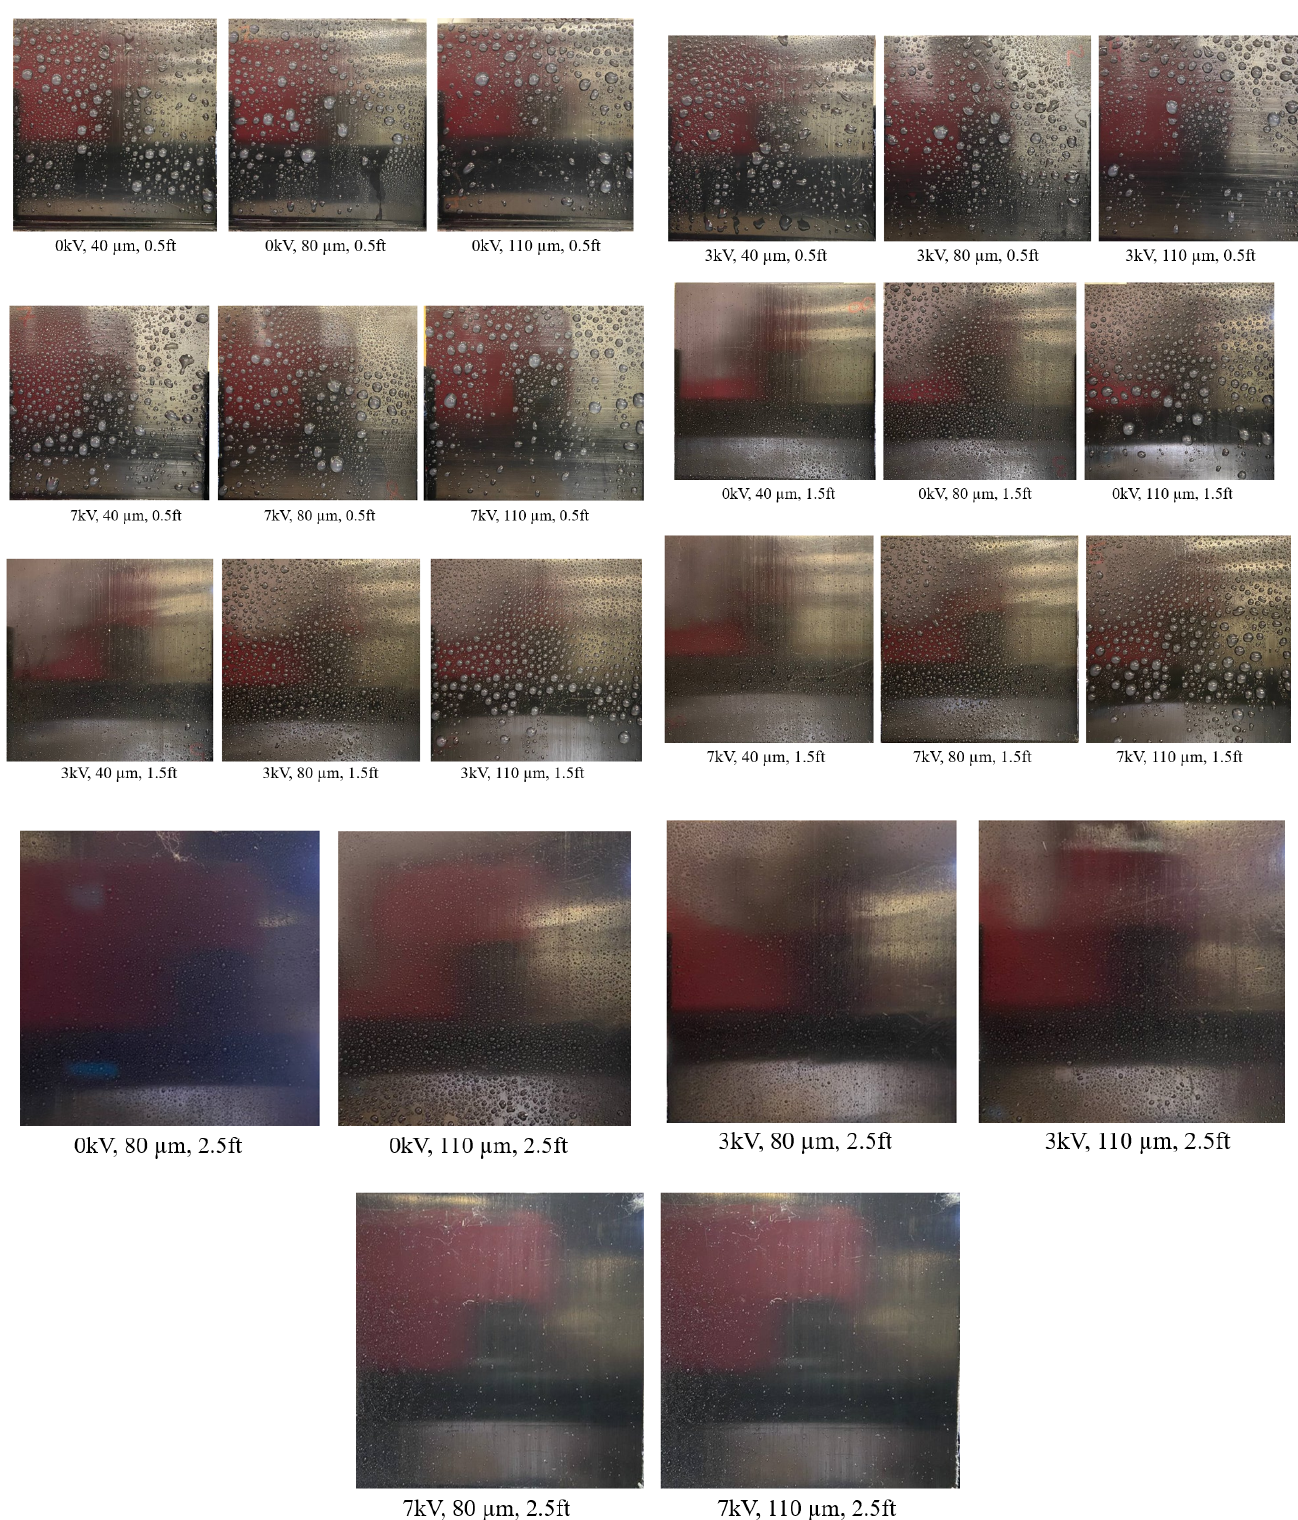
Figure A17. Polypropylene: qualitative images of electrostatic deposition under various system